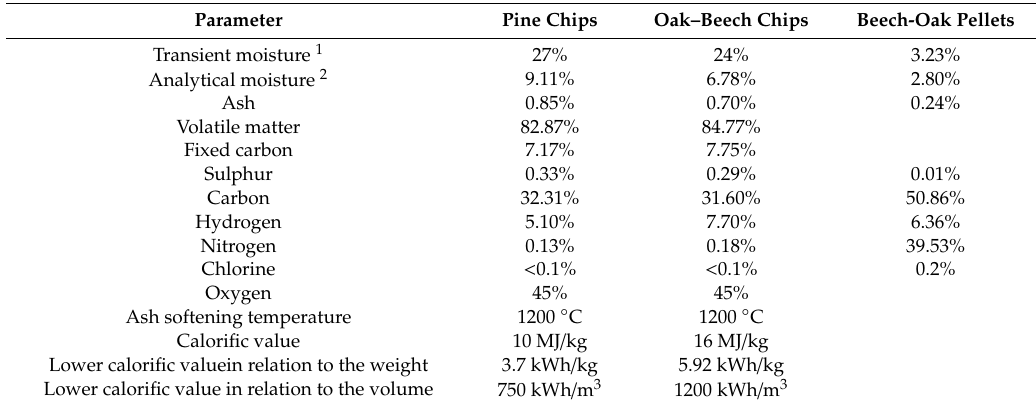
Table 3. Physicochemical parameters of the fuels investigated